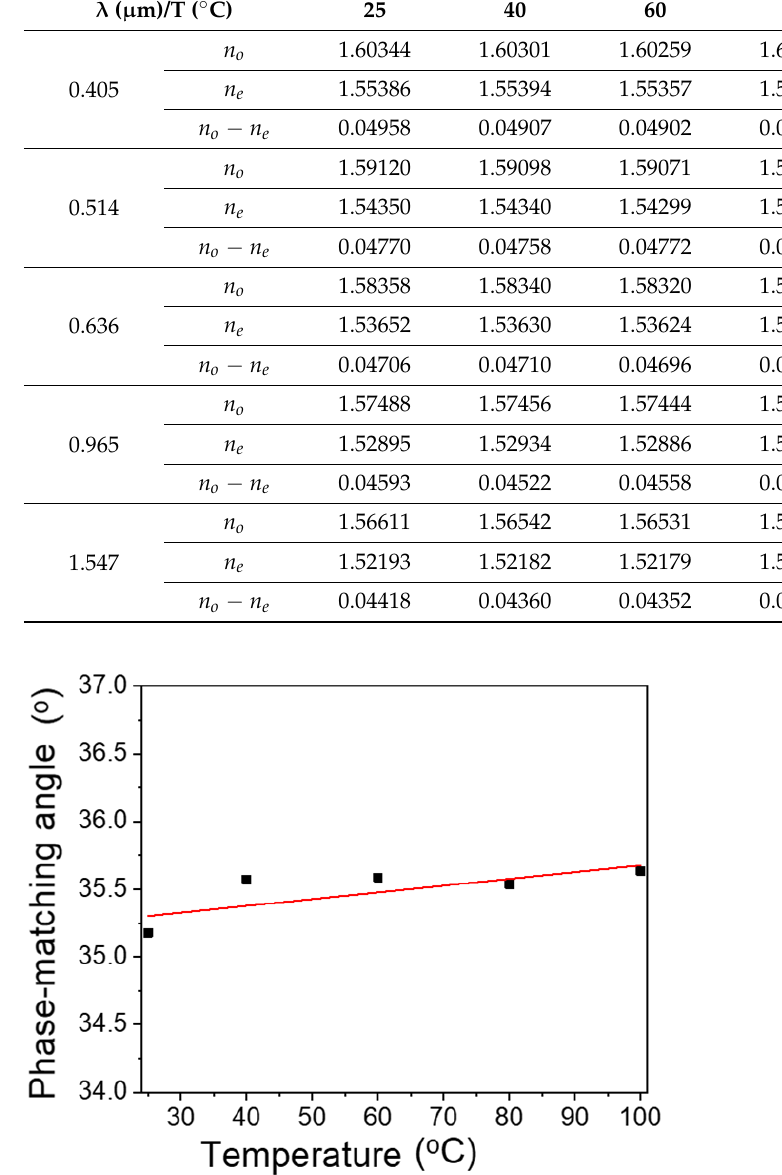
Figure 8. The type I phase-matching angles of KBOB at different temperatures. Table 1. Thermal refractive index at different temperatures.